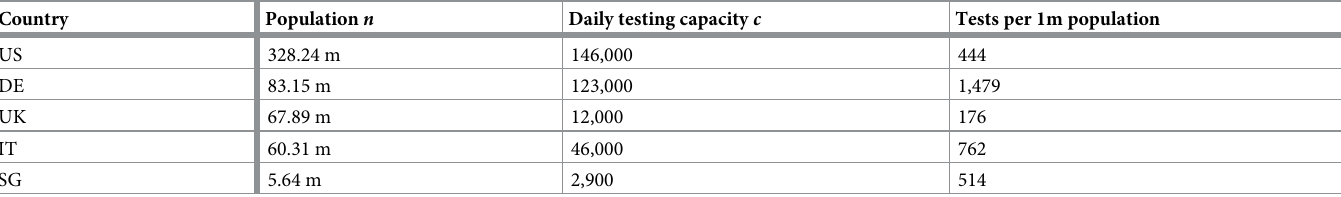
Table 1. Data used in the simulations based on